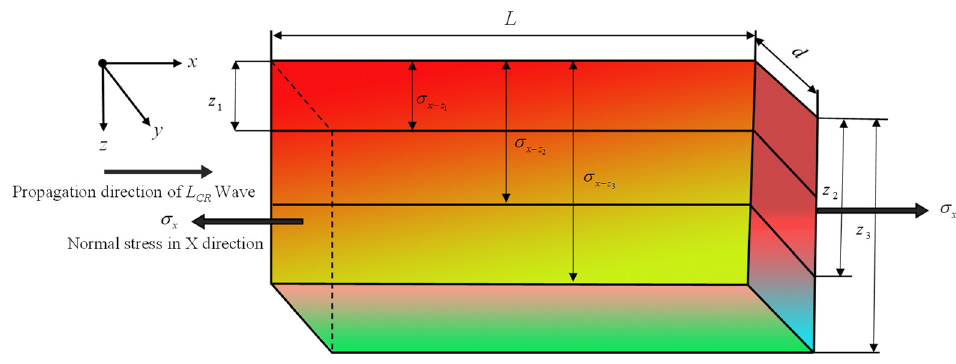
Figure 3. The depth distribution model of horizontal normal stress.